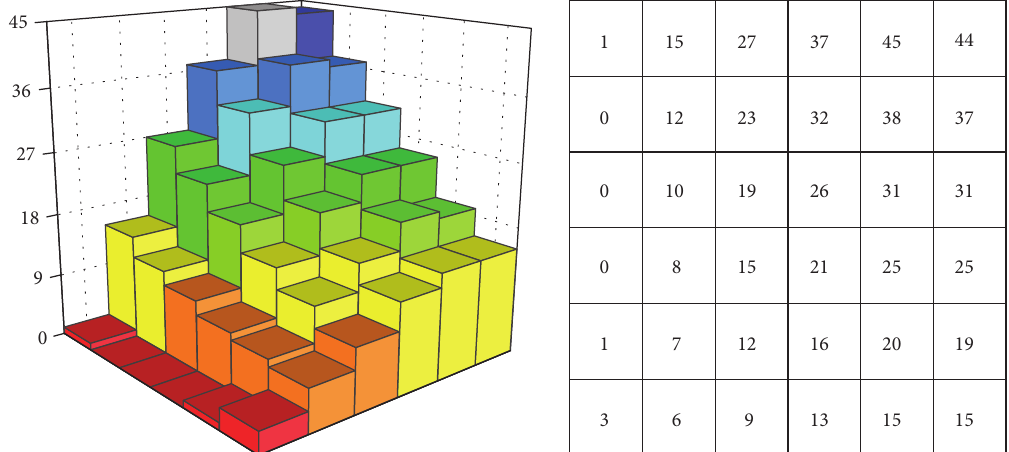
Figure 2: Topographical sample (approximately showing real topography).